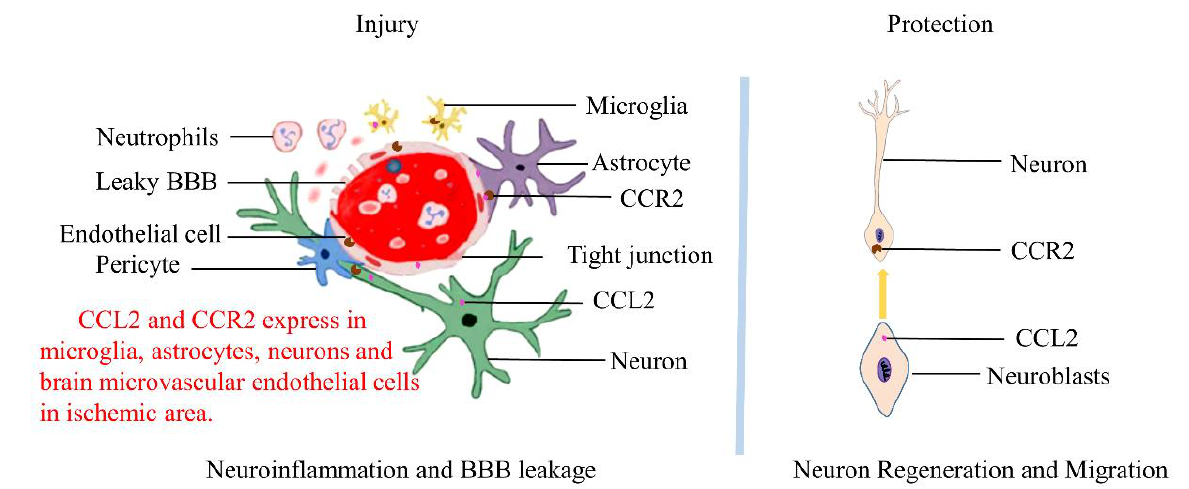
Figure 2. The role of CCL2/CCR2 in cerebral ischemia-reperfusion. The expression of CCL2 and CCR2 in the ischemic area is increased sharply in neurons, astrocytes, microglia, and endothelial cells for 24 h after cerebral ischemia-reperfusion. These induce neuroinflammation and blood-brain barrier leakage, resulting in neurological injury ( Left ). On the other hand, the migration of neuroblasts to the injured area is CCL2/CCR2-dependent ( Right ). As such, the CCL2/CCR2 signaling pathway promotes neuron regeneration and the recovery of neural function after cerebral ischemia.